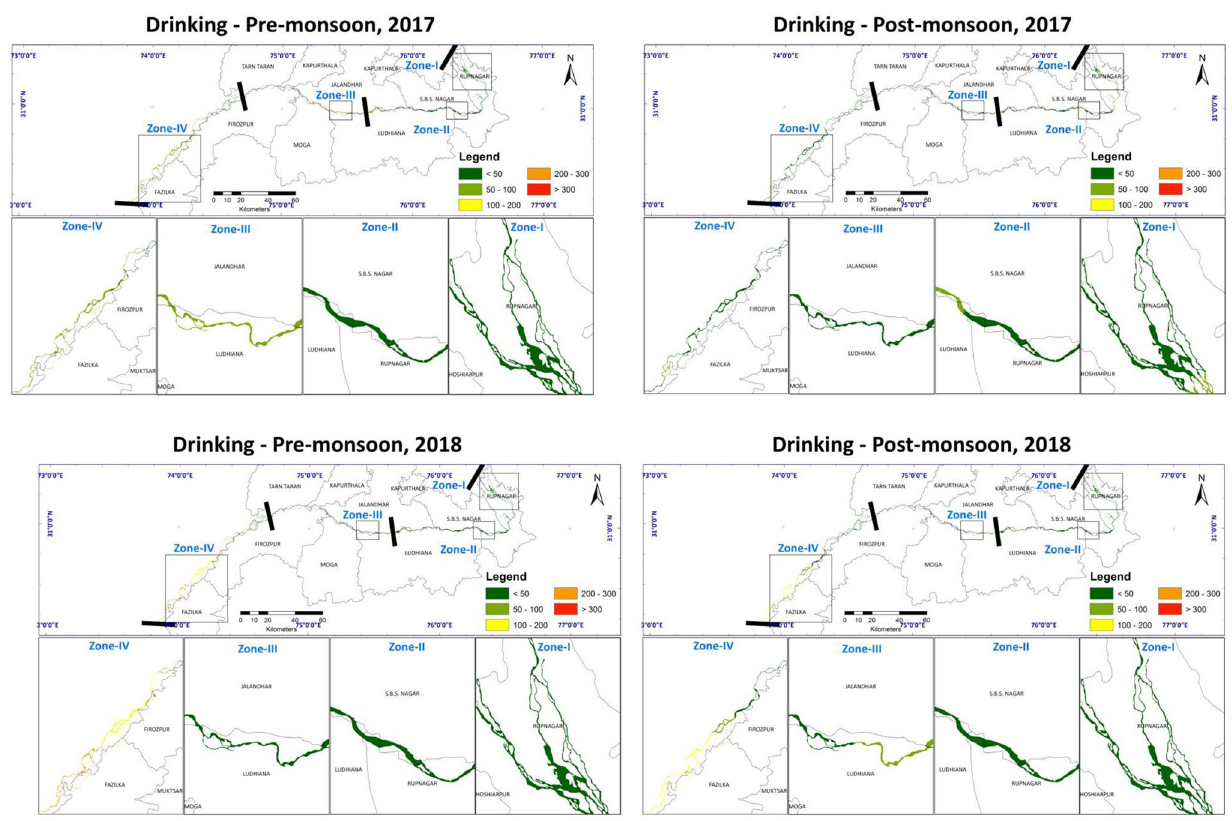
Fig. 2 Spatio-temporal variations in water quality index (for drinking purposes) of water samples collected from the Sutlej